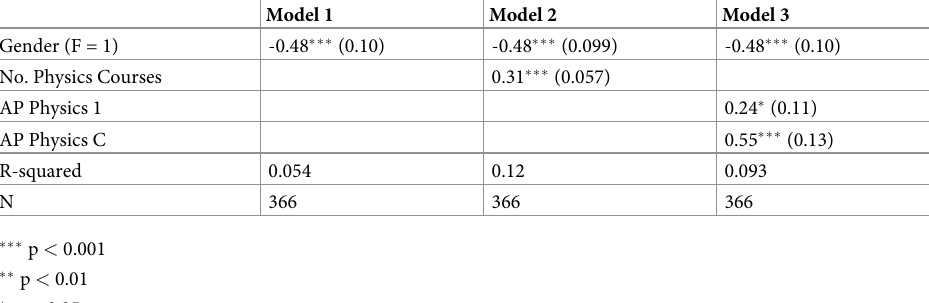
Table 3. Multivariable linear regression predicting the effects of gender and high school physics coursework on exam